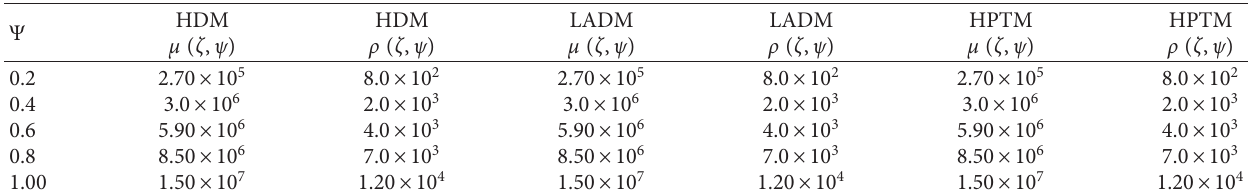
Figure 4: HPTM solutions of μ ( ζ , Ψ ) and ρ ( ζ , Ψ ) at different fractional orders c � 0 . 5 , 0 . 6 , 0 . 8 , 1 and Ψ � 1. Table 1: Comparison of HDM [36], LADM [37], and HPTM at ζ � 1 and c �